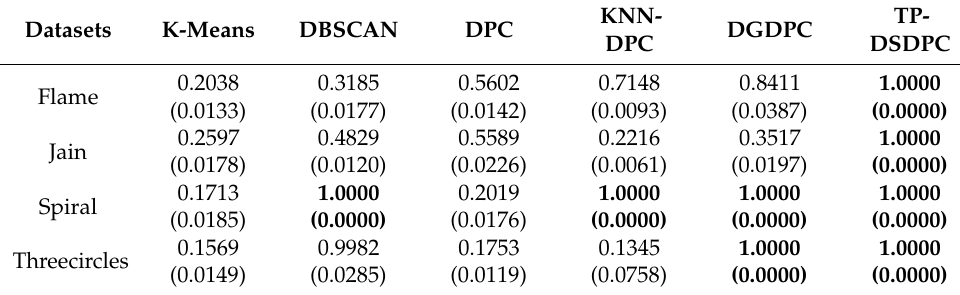
Table 5. The NMI of the six algorithms on nine synthetic datasets. Table 5. The ACC of the six algorithms on nine synthetic